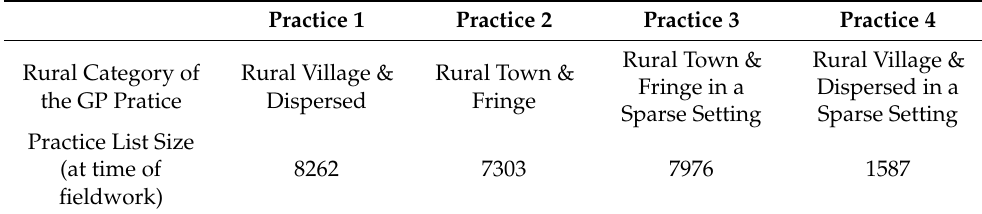
Table 1. Primary Care Recruitment Site